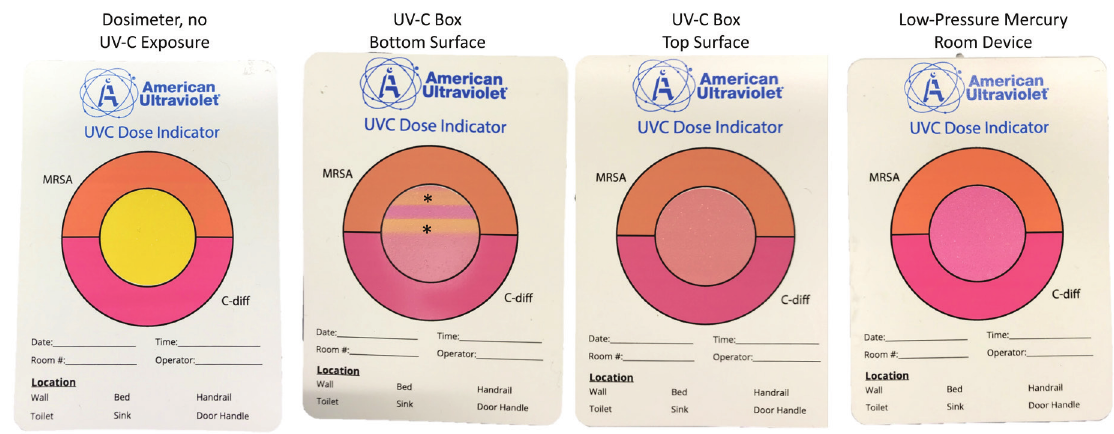
Figure 4. Pictures showing colorimetric indicators placed adjacent to respirators during ultraviolet-C